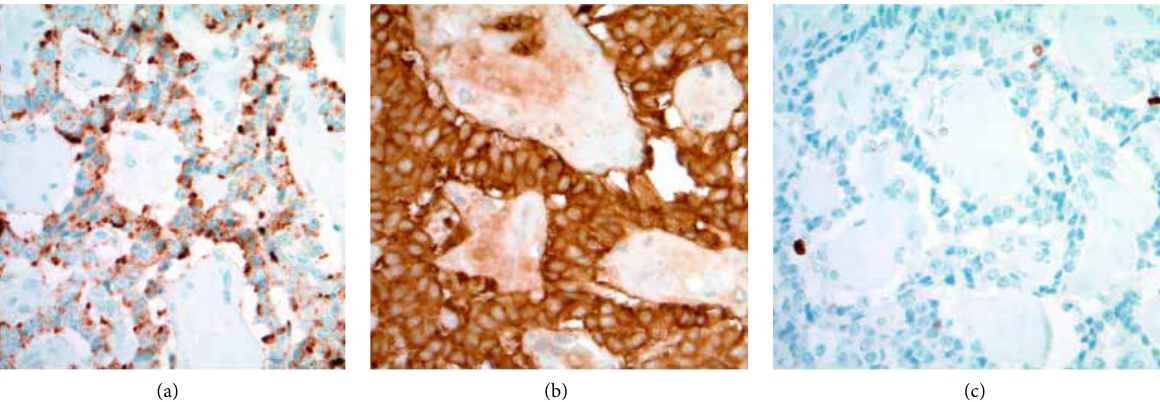
Figure 11: (a) Diffuse granular cytoplasmic immunoreactivity is present in the ribbons of lesional epithelial cells between fibrous spheroids (Chromogranin A immunohistochemistry, 400X). (b) Diffuse and strong homogenous cytoplasmic immunoreactivity is confirmed in the epithelial cells (Synaptophysin immunohistochemistry, 400X). (c) Very rare epithelial nuclei (<3% of lesional cells) show immunoreactivity with the proliferation marker (Ki-67 immunohistochemistry,